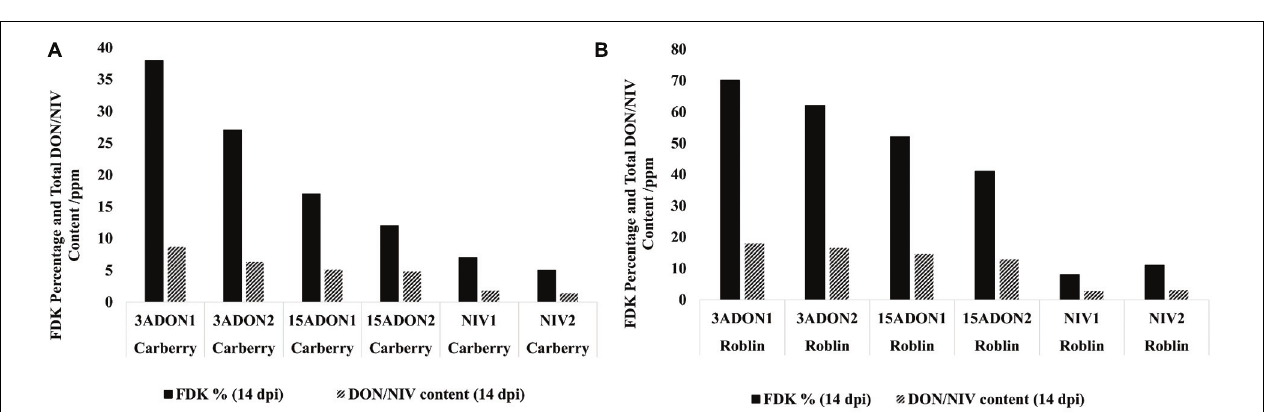
FIGURE 4 | Mean Fusarium head blight disease severity in (A) moderately resistant cultivar Carberry and (B) susceptible cultivar Roblin after inoculating with different chemotypes of Fusarium graminearum at 7 and 14 days post-inoculation. Means with the same letters for Fusarium head blight disease severity are not significantly different.